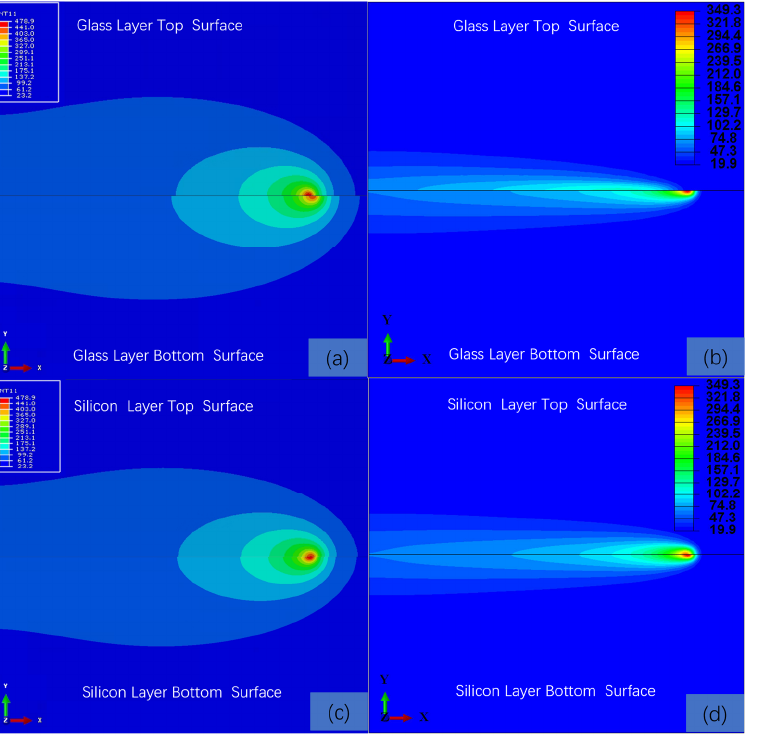
Figure 5. ( a ) Temperature field distribution on the upper and lower surfaces of the low speed glass layer. ( b ) Temperature field distribution on the upper and lower surfaces of the high speed glass layer. ( c ) Temperature field distribution on the upper and lower surface of the low speed silicon layer. ( d ) Temperature field distribution on the upper and lower surface of the high speed silicon layer.